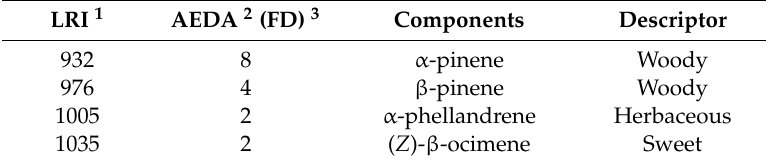
Table 3. Olfactometric analysis and sensory descriptors of D. mutisii EO with DB-5ms column.